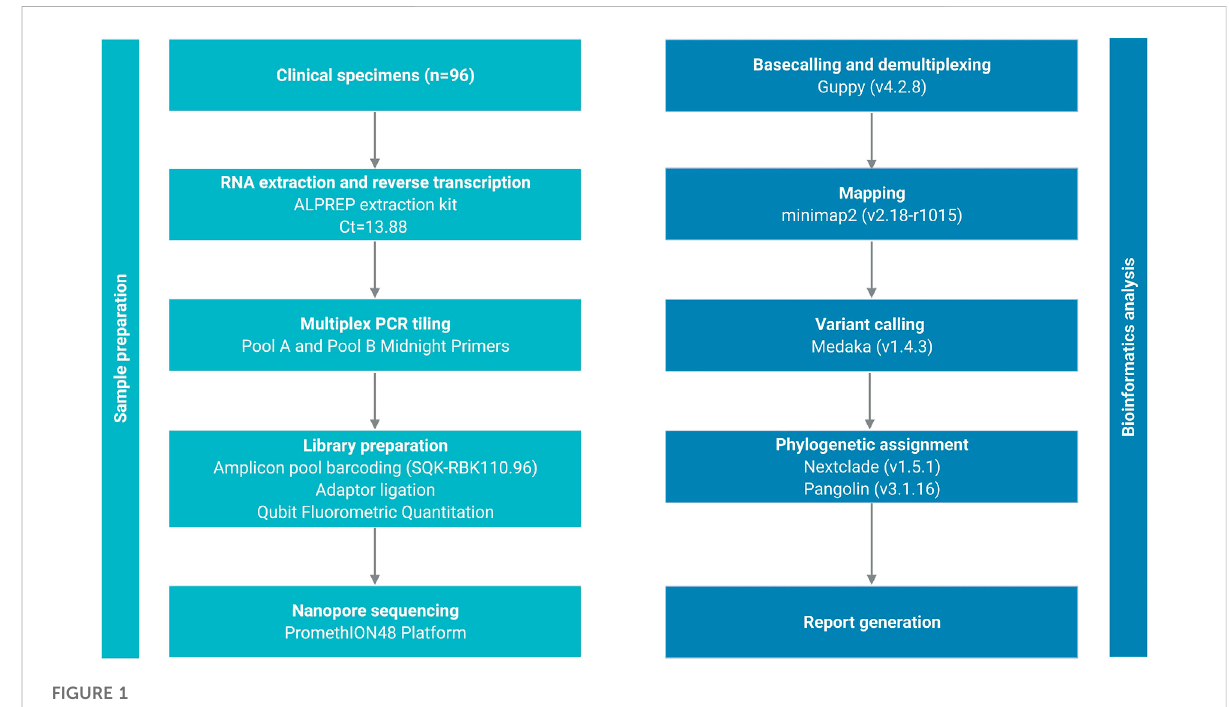
FIGURE 1 SARS-CoV-2 whole-genome sequencing and analysis work fl